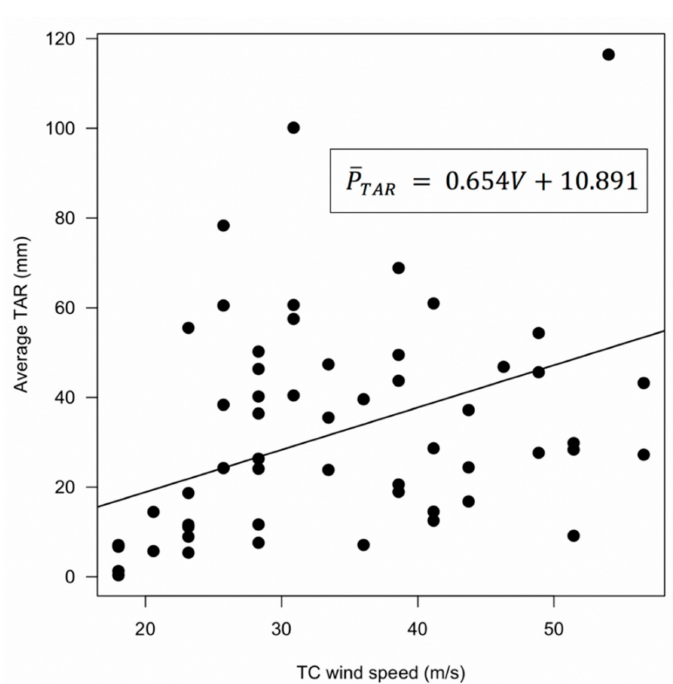
Figure 3. Linear relationship between the TC wind speed (V, m / s) and the average typhoon-induced accumulated rainfall (TAR) ( P TAR , mm). The average TAR and TC wind speed were obtained using the most similar typhoons from 55 storms and 75